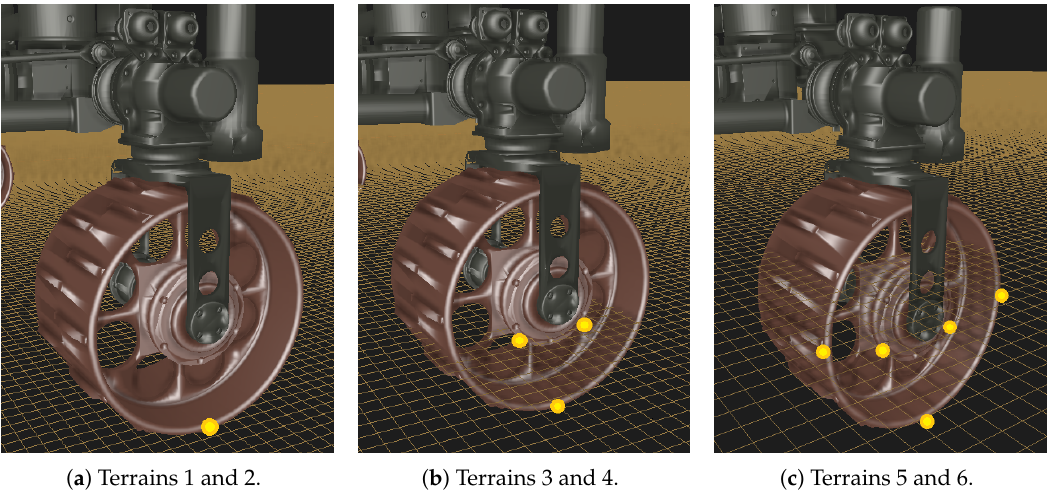
Figure 6. Vortex Studio defined contact points for different terrains. Depending on the Stiffness and Damping parameters, these contact points can be increased or decreased. ( a ) Terrains 1 and 2; ( b ) Terrains 3 and 4; ( c ) Terrains 5 and 6.